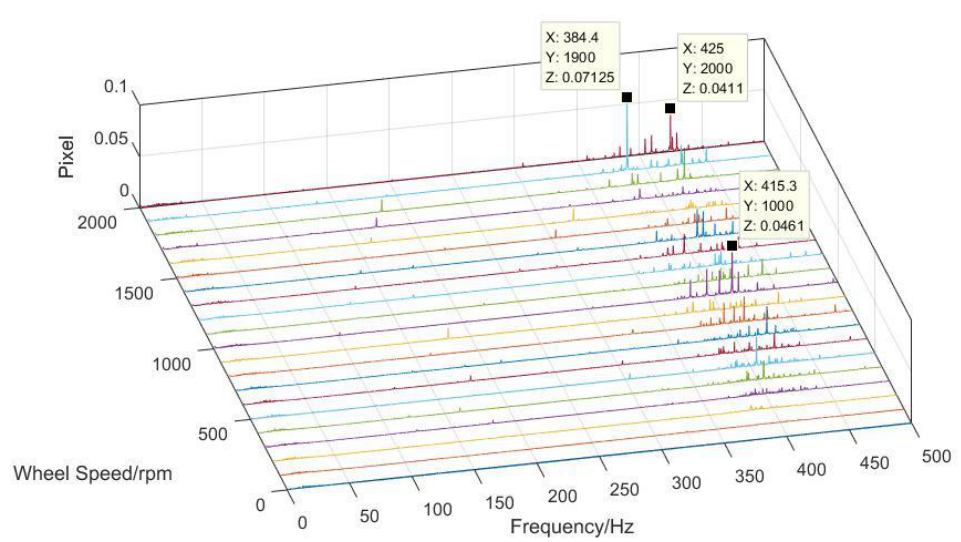
Figure 12. The pixel offset results of the test based on acceleration sensors in the frequency domain.